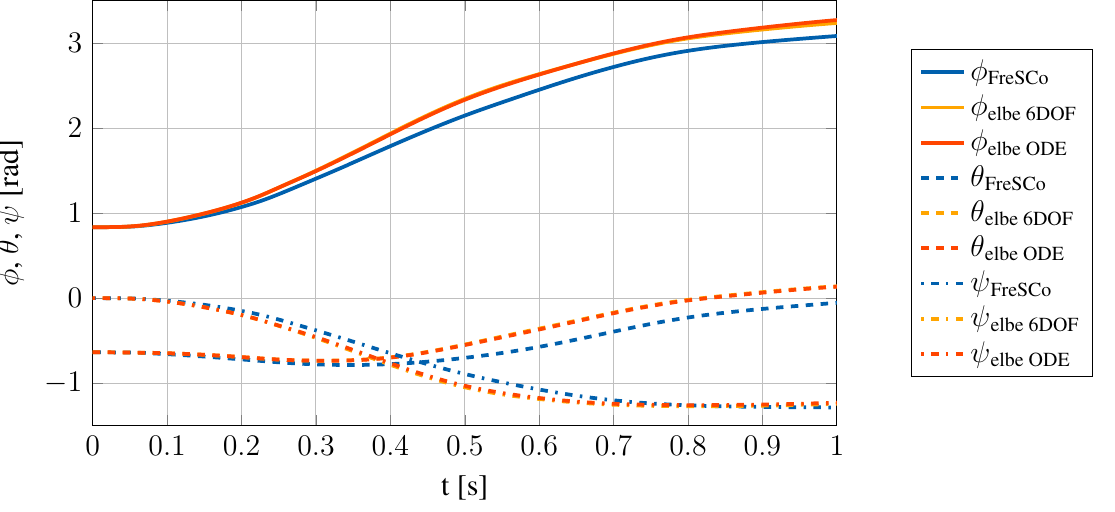
Figure 14. Freely falling cube: Euler angles. Comparison of FreSCo + results with ELBE -ODE (Open Dynamics Engine) and ELBE -6DOF (quaternion-based motion